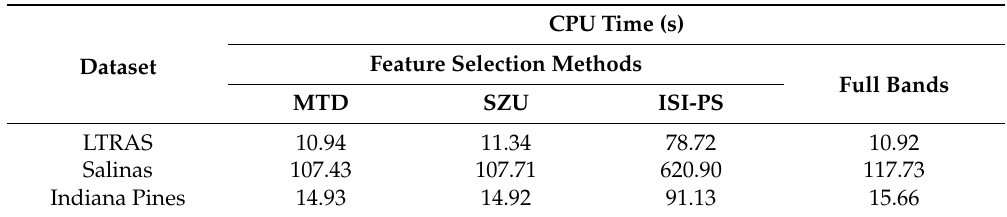
Table 6. Computational times of unmixing using full bands and reduced bands from different band selection